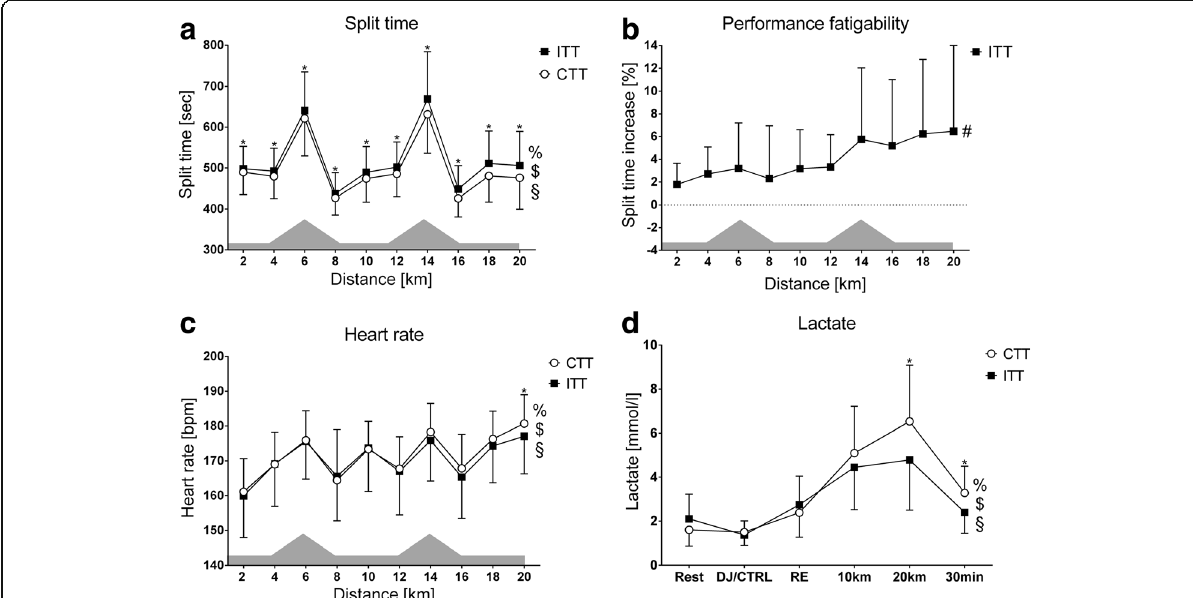
Fig. 3 Differential responses in markers of performance fatigability. Panels show: a = split time; b = performance fatigability; c = heart rate; d = blood lactate concentration. Note the differences in the x -axes of blood lactate concentrations due to different sampling times. Performance fatigability is indicated by the percentage increase in split time during the intervention time trial compared to control time trial and assessed via one-way repeated measures ANOVA. The shaded topography represents the course profile of the 20-km treadmill time trial. Abbreviations: # = main time effect; % = time×trial interaction effect; $ = simple (main) time effect for intervention trials; § = simple (main) time effect for control trials; * = simple (main) trial effect; ITT = intervention time trial; CTT = control time trial; DJ = drop-jump protocol; CTRL = control; RE = running